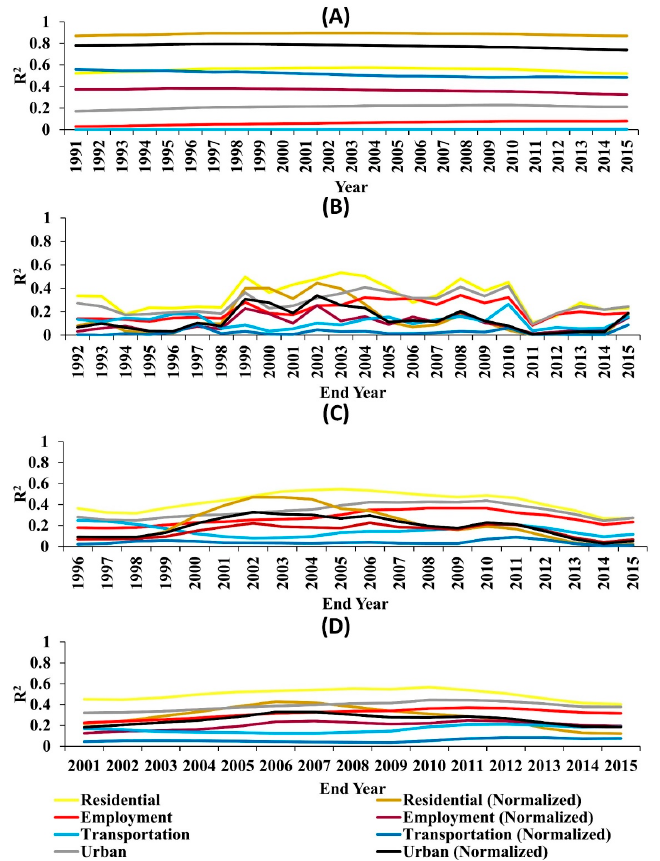
Figure 5. R 2 between population and land use and their changes. The legend shows the corresponding land use, and population is the independent variable for all linear regression. Normalized refers to both population and the land use being normalized by the size of districts. The x -axes of ( B – D ) show the end year of the time interval. ( A ) annual population and land use; ( B ) annual change of population and land use; ( C ) 5-year change of population and land use; ( D ) 10-year change of population and land use. R 2 -values derived from population, land use area, and their changes were derived from the same year or same period without time lag.